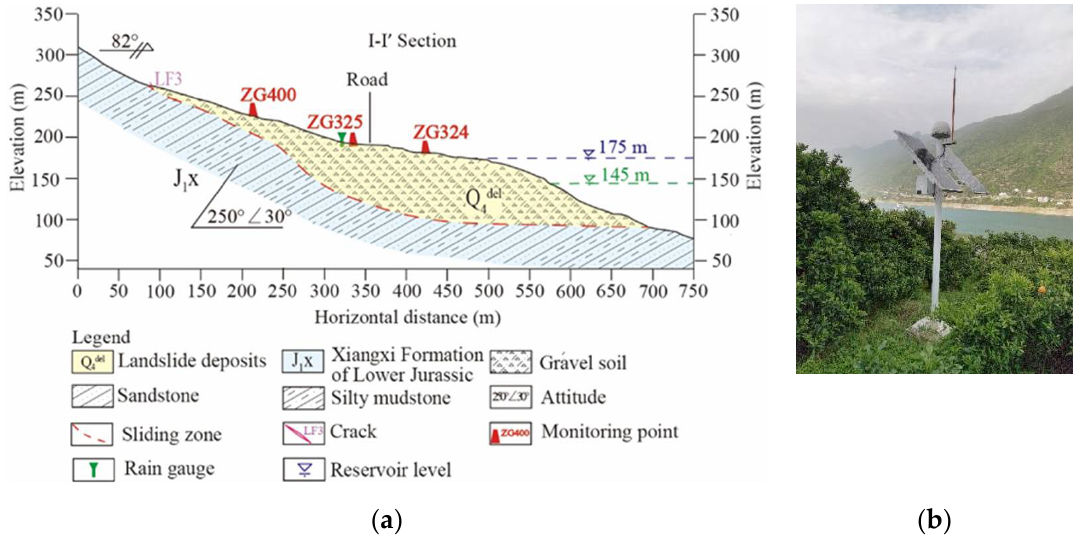
Figure 4. ( a ) Geological cross-section I-I’; ( b ) the GNSS monitoring station.